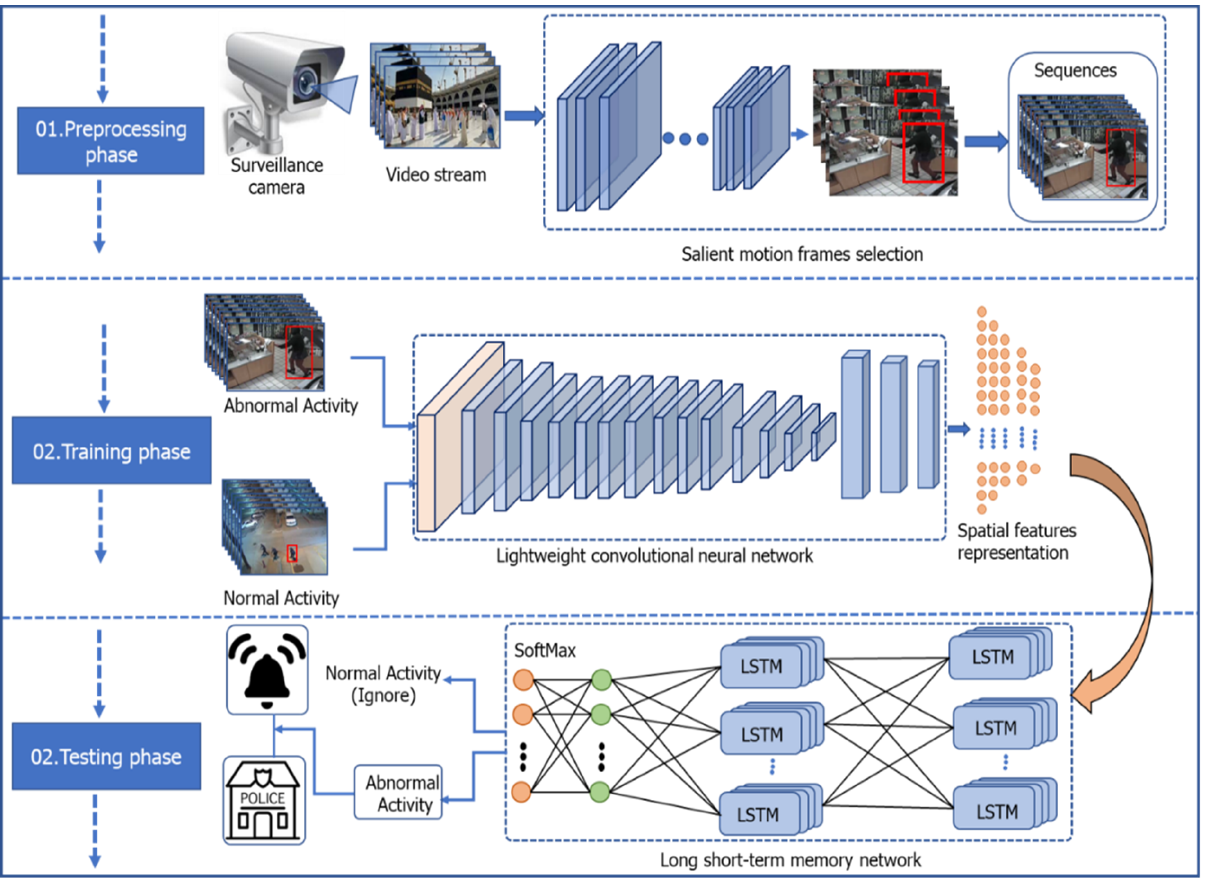
Figure 1. The proposed framework of violent activity recognition.